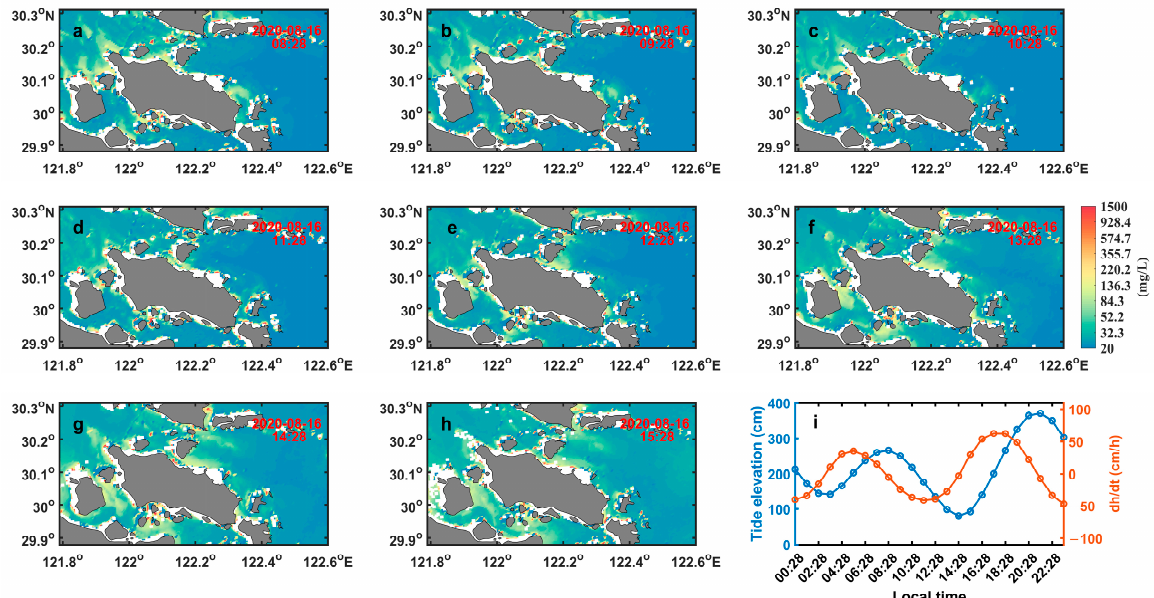
Figure 11. Same as Figure 10 but for the middle tide on 16 August 2020.